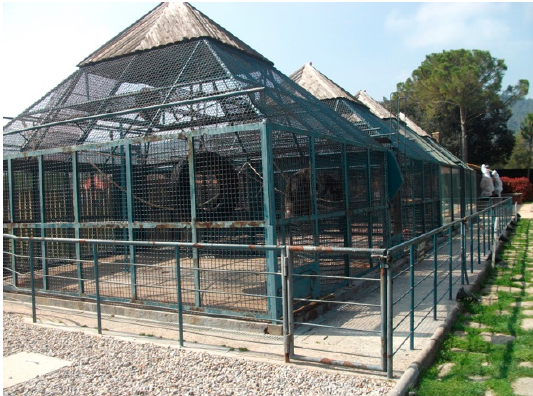
Figure 1. Outdoor cages of the chimpanzees when living as